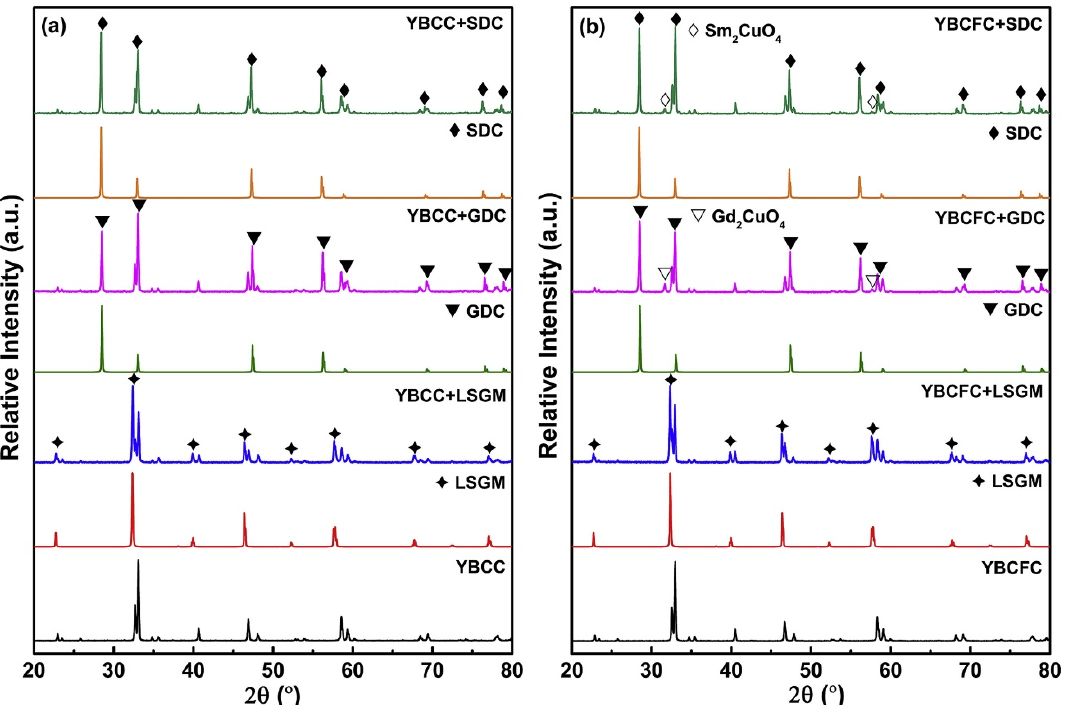
Figure 4. XRD patterns of the samples: YBCCO–SDC, YBCCO –GDC, and YBCCO –LSCM: ( a ) YBCFC–SDC, YBCFC–GDC, and YBCFC–LSCM ( b ) calcined at 1123 K for 10 h in air (reproduced